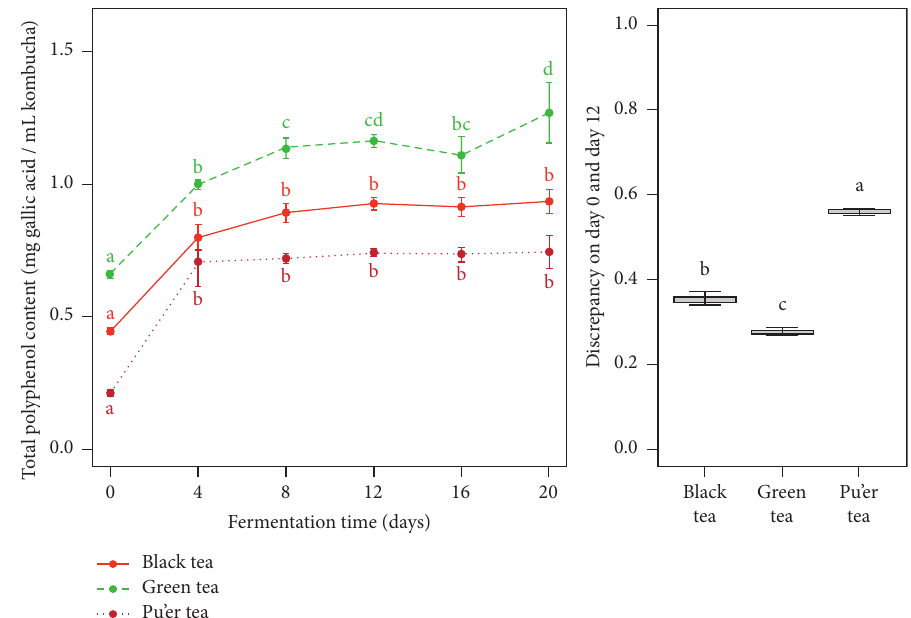
Figure 2: Total polyphenol content (a) and discrepancy value (b) during fermentation of kombucha prepared from green, black, and pu’er teas. Different letters indicate significant differences between the tea groups ( p < 0 .